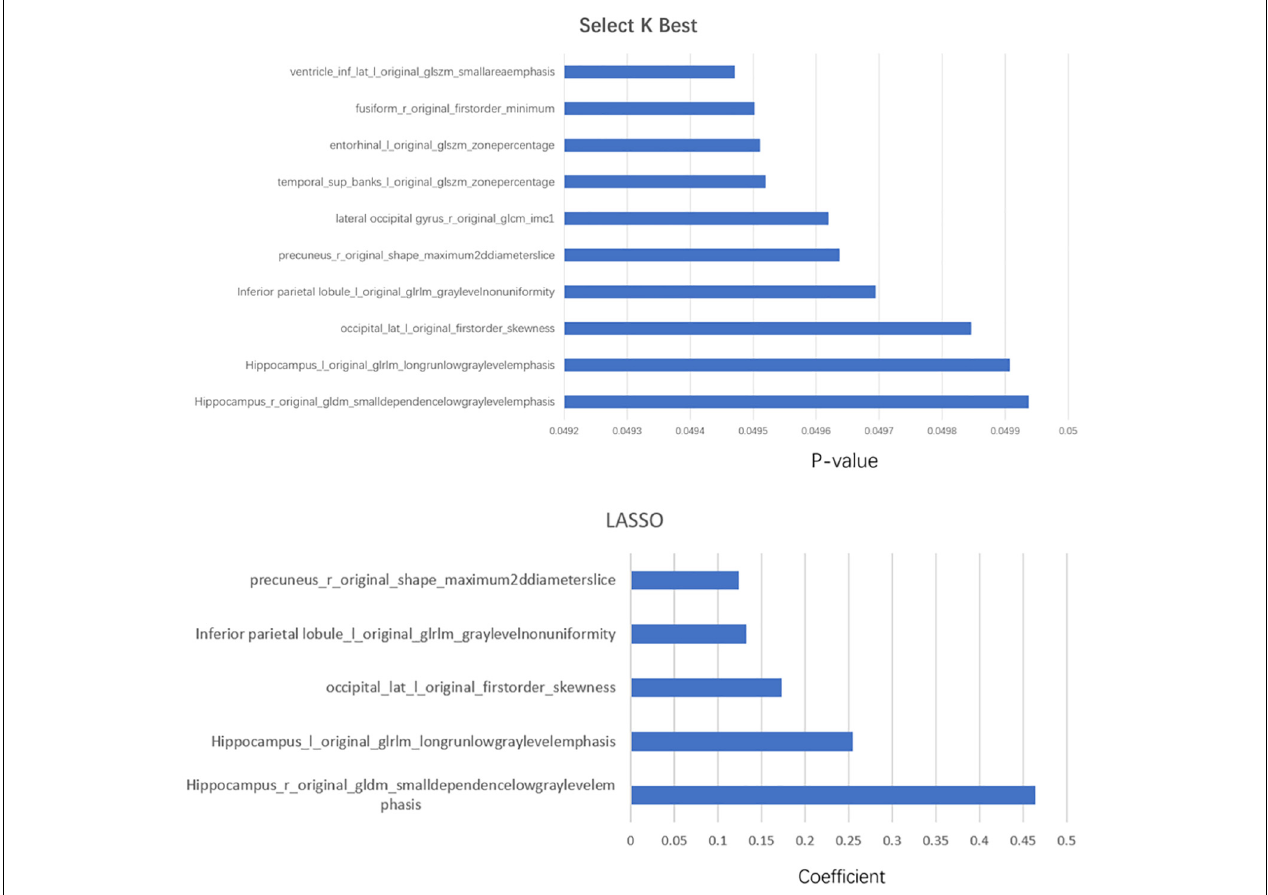
FIGURE 4 | The combination of statistically significant brain regions and radiomic features in the two-step dimensionality reduction process. In the first step, Select K Best, more than 10 radiomic features, are screened out; only the top 10 are listed in this